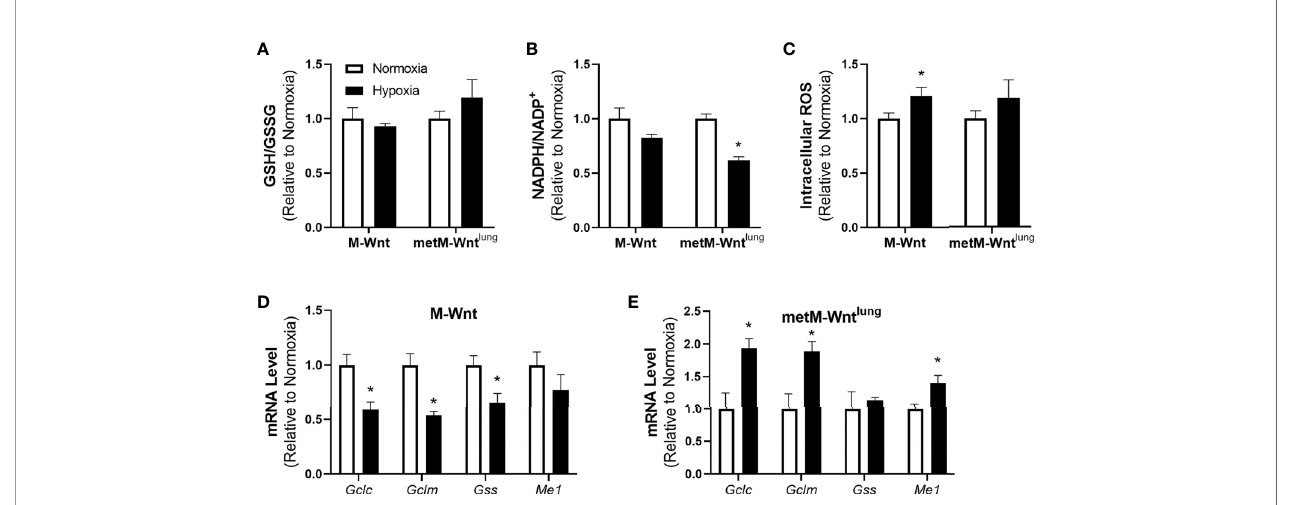
FIGURE 2 | Effect of hypoxia on oxidative stress markers. Ratios of GSH/GSSG (A) , NADPH/NADP + (B) , and levels of intracellular ROS (C) were determined. Levels of genes involved in antioxidant defense were assessed by qRT-PCR in normoxic and hypoxic M-Wnt (D) and metM-Wnt lung (E) cells. Results are expressed as mean + SEM. Asterisk (*) indicates P < 0.05 relative to normoxia,